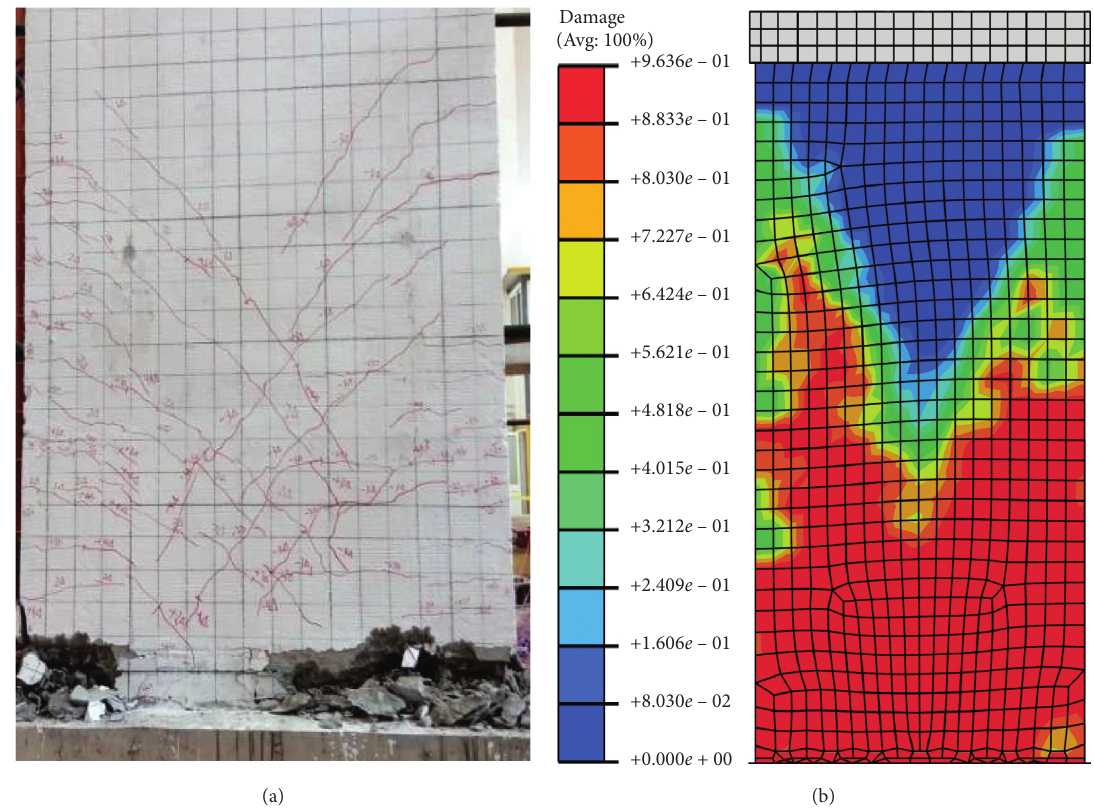
Figure 12: (a) Damage distribution of the test specimen and (b) finite element model. Note: Avg, average.